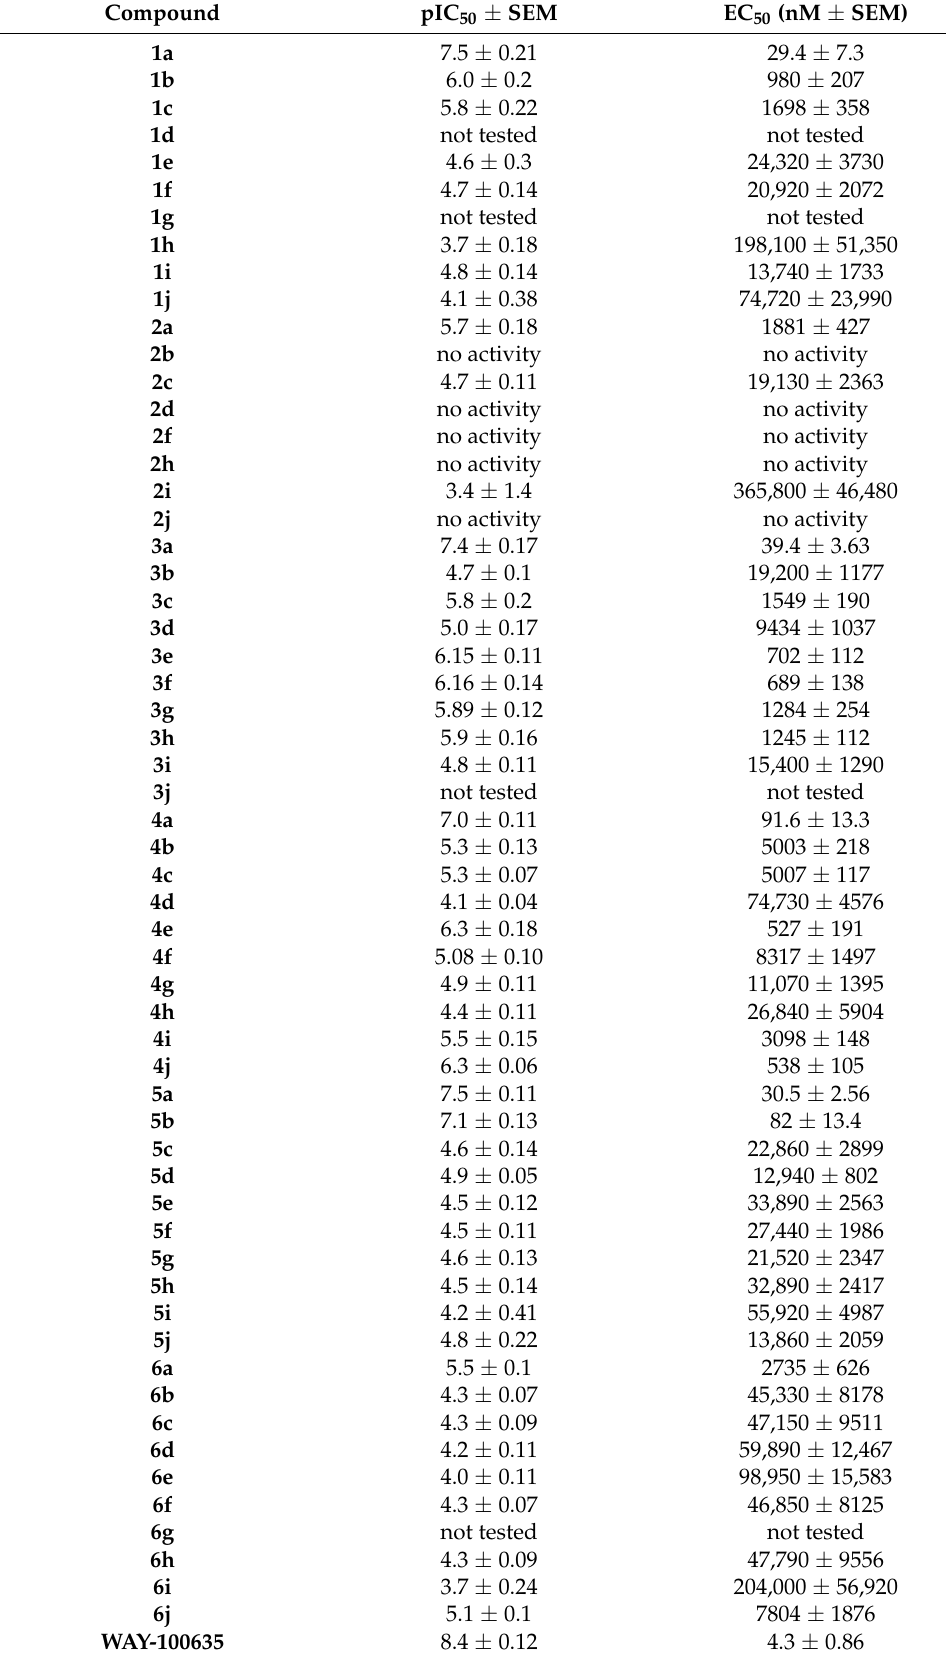
Table 3. Antagonistic activity of compounds for the 5-HT 1A